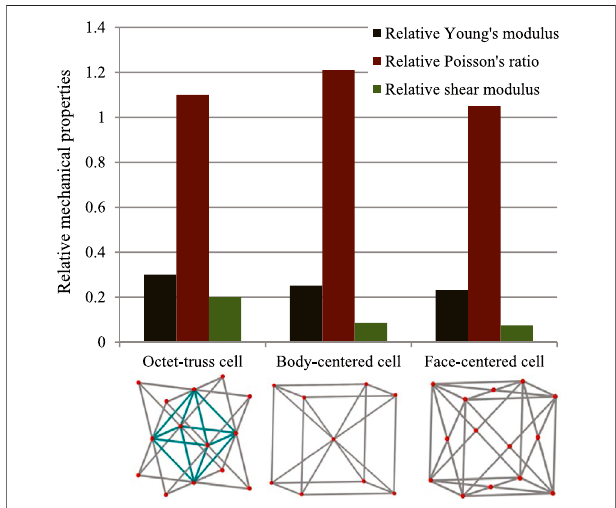
FIGURE 4 | Relative effective mechanical properties of three typical stretching-dominated unit cells.